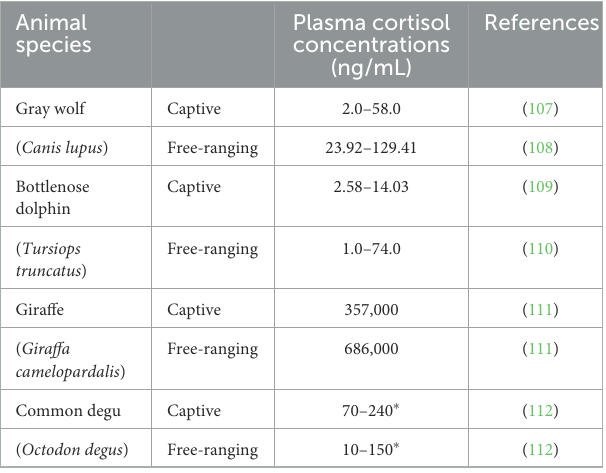
TABLE 5 Plasma cortisol concentration in some captive and free-ranging species. Animal